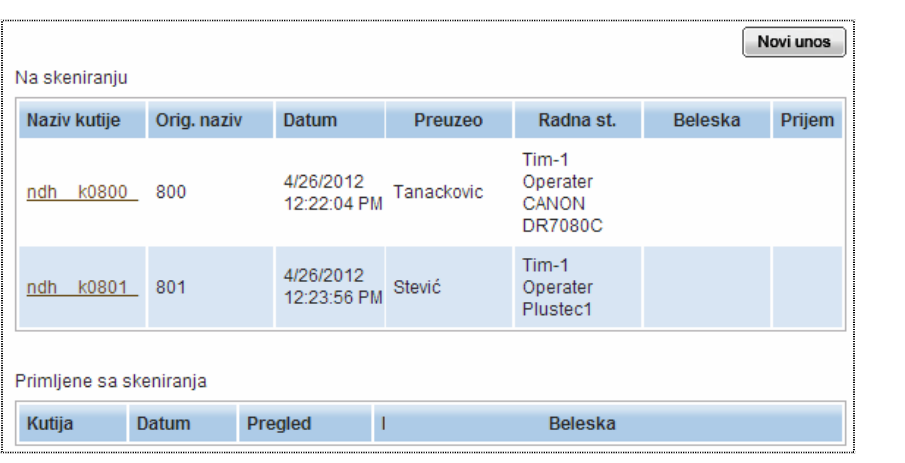
Figure 4 – List of tasks given to scanner operators by the supervisor Sa druge strane, operater za skeniranje dokumenata logovanjem na aplikaciju dobija spisak zadataka koje treba da izvrši i radi skeniranje svakog dokumenta pojedina č no, uz snimanje na lokalnoj radnoj stanici (slika 5). Dokumenta se snimaju po redu i dobijaju nazive od 0 (omot